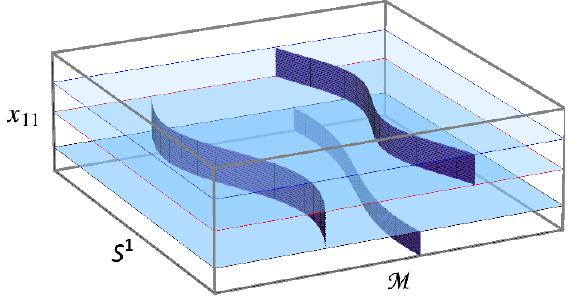
Figure 1. Open M2-branes stretched between a stack of M5-branes. If the latter are separated in their transverse space (not depicted here), in the type IIA limit this bound state reduces to D2-branes stretched between